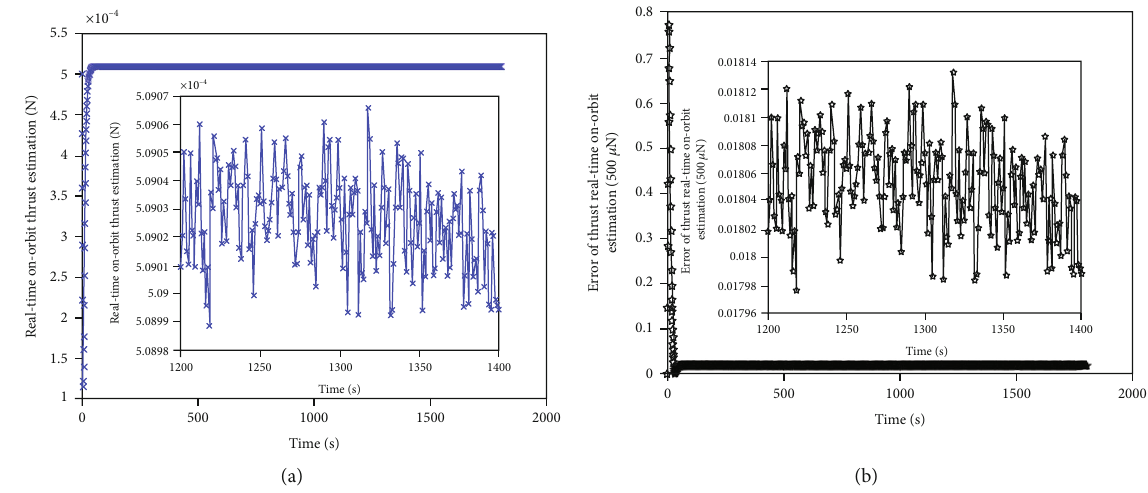
Figure 9: Real-time on-orbit estimation results and errors of 500 μ N thrust.